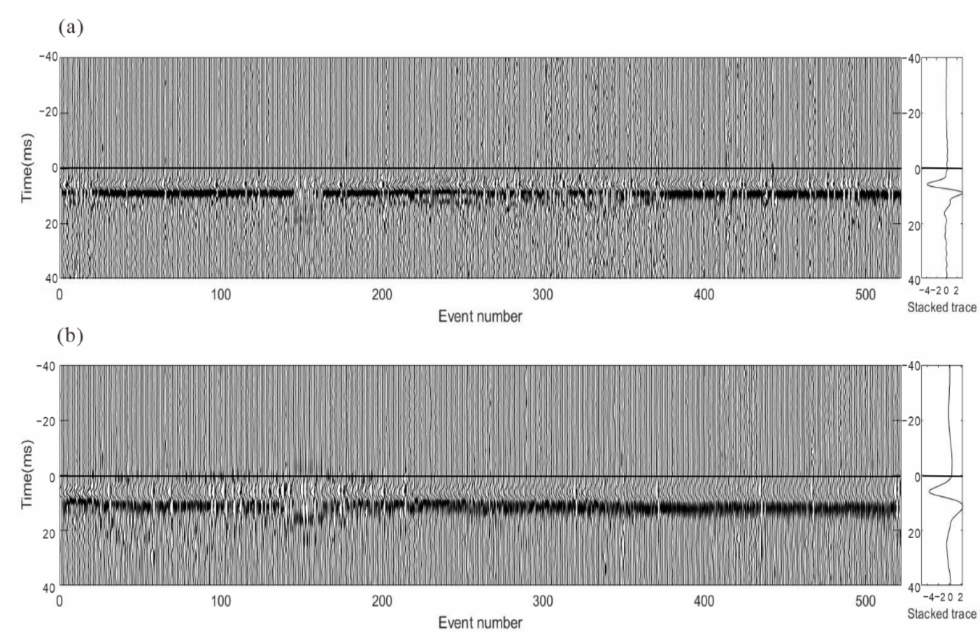
Figure 18. The stacked waveform gathers of all events after inter-event event refinement. The horizontal lines show the arrival times of the stacked waveforms. ( a ) P wave; ( b ) S wave. The recordings are processed by energy balancing and polarity